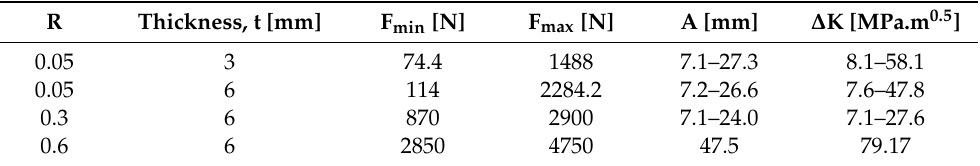
Figure 1. Geometry of C(T) specimen. Table 2. Load parameters.